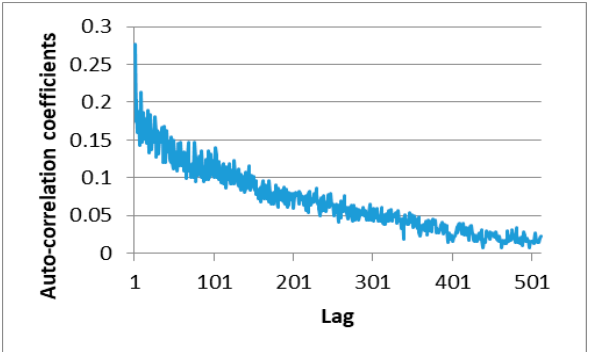
Figure 7. Autocorrelation coefficients of received data in first minute (21:45) of trace obtained in the sixth hour.